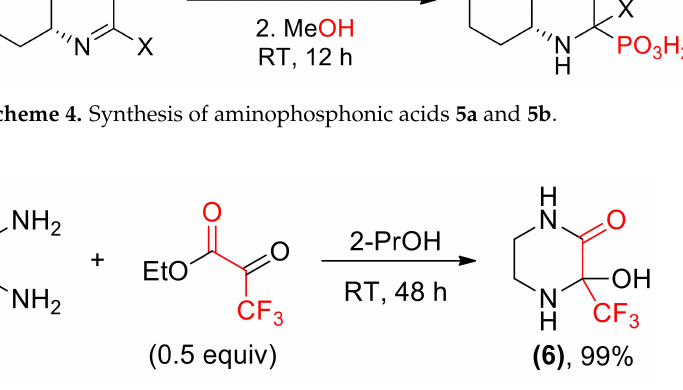
Scheme 5. Synthesis of imine hydrate 6